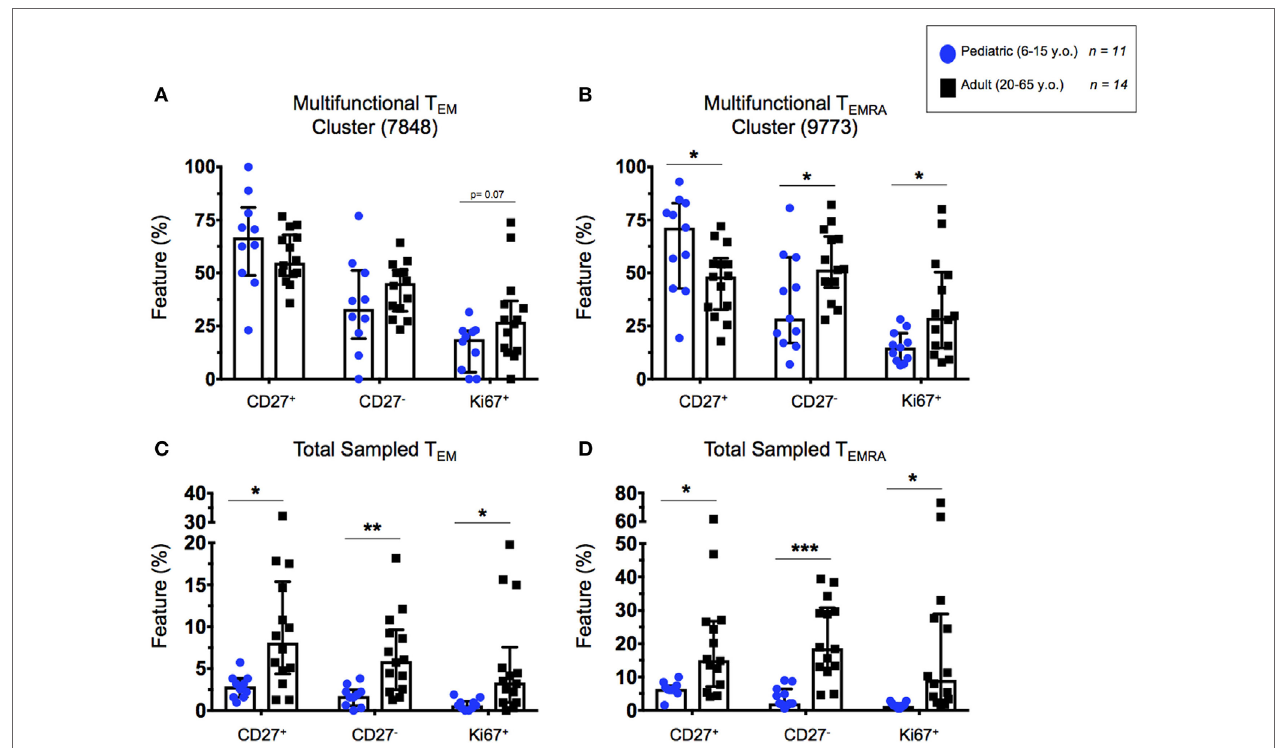
FigUre 7 | Highly multifunctional CD8 + T cell functional states. Scatter plots showing the percentages of highly multifunctional CD8 + T cells as defined by CITRUS node isolation. (a) T EM and (B) T EMRA cells within the chosen highly multifunctional nodes (see Figure 6 ) showing proportions of cytotoxic (CD27 − ) or proliferative (CD27 + and Ki67 + ) multifunctional CD8 + T cells in adults and children. (c) T EM and (D) T EMRA populations showing highly multifunctional CD27 + . CD27 − , and Ki67 + cells from within the total CITRUS sampled CD8 + memory T cell subsets, exhibiting the proportion of highly multifunctional cytotoxic or proliferative phenotypes from within the each memory subset. Populations split among 6–15-year-old pediatric ( n = 11) and adult ( n = 14) participants. Bars represent medians with whiskers indicating interquartile ranges. Scatter plot statistics were analyzed by unpaired t -test (* p < 0.05; ** p < 0.01; and *** p <